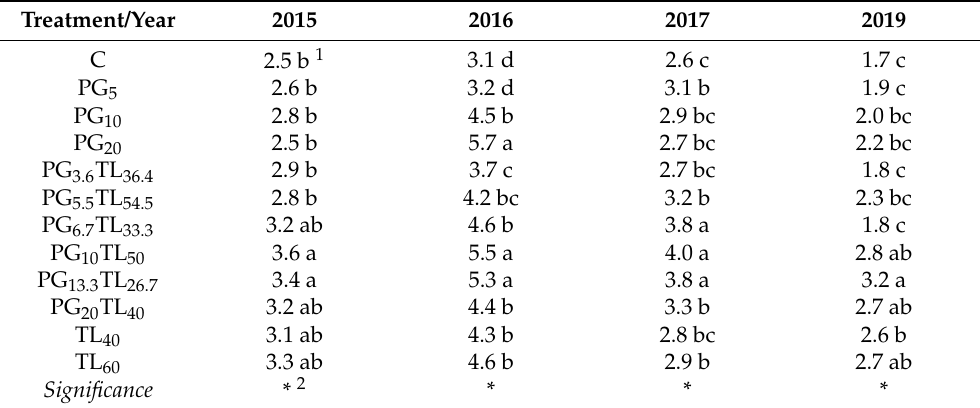
Table 6. Effect of treatments and years on the soil structural coefficients (K s , 0–20 cm).